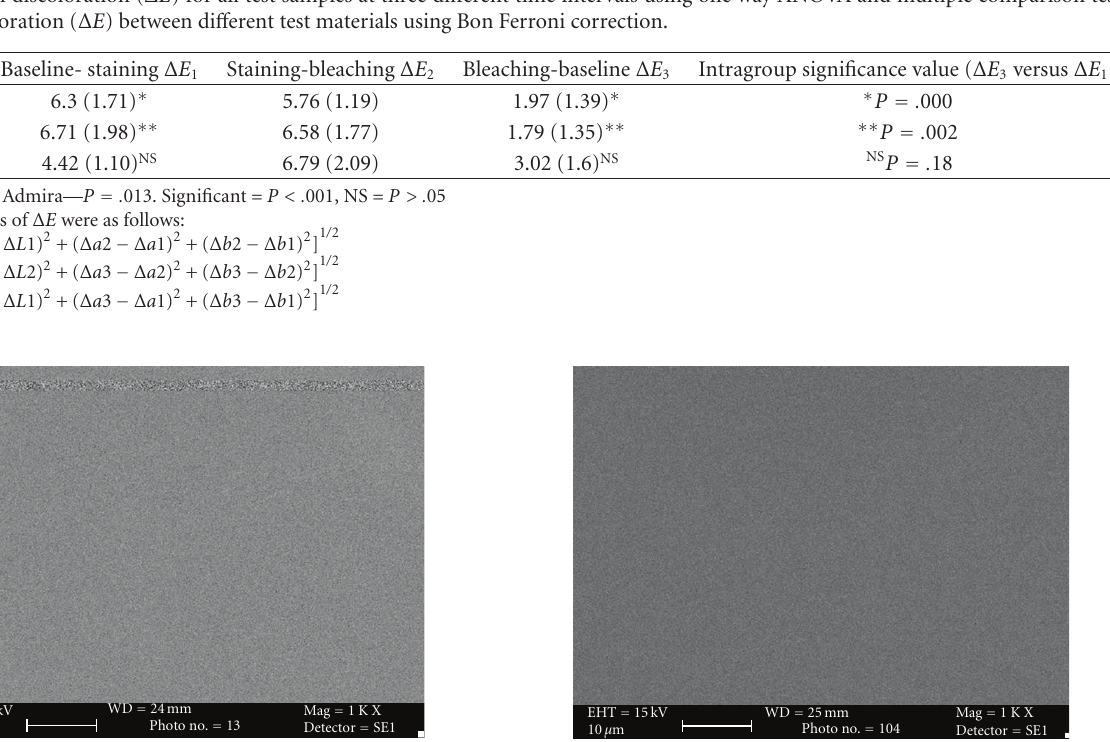
Figure 2: Photomicrograph of Filtek Z350 before bleaching at 1000x.